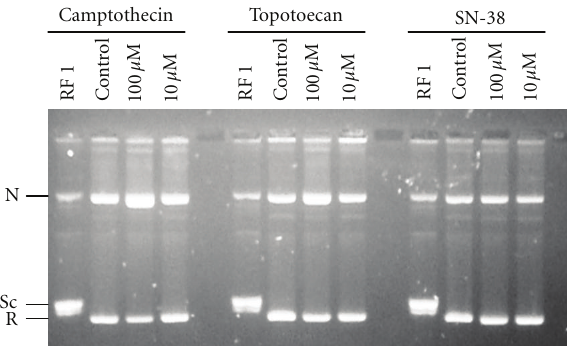
Figure 3: E ff ects of CPT, topotecan, and SN-38 on the stabilization of covalent TopIB-DNA cleavable complexes. Standard cleavage assay (Material and Methods) were carried out with final concen- trations of CPT, topotecan, and SN-38 of 10 and 100 μ M. CPT was added at a final concentration of DMSO of 1%. The reactions were incubated at 30 ◦ C for 30 minutes and then stopped with a mixture of 1% SDS and 6.1 μ g of proteinase K. The reaction products were resolved in a 1% agarose gel and visualized by ethidium bromide staining. Sc: supercoiled DNA, R: relaxed DNA, N: nicked